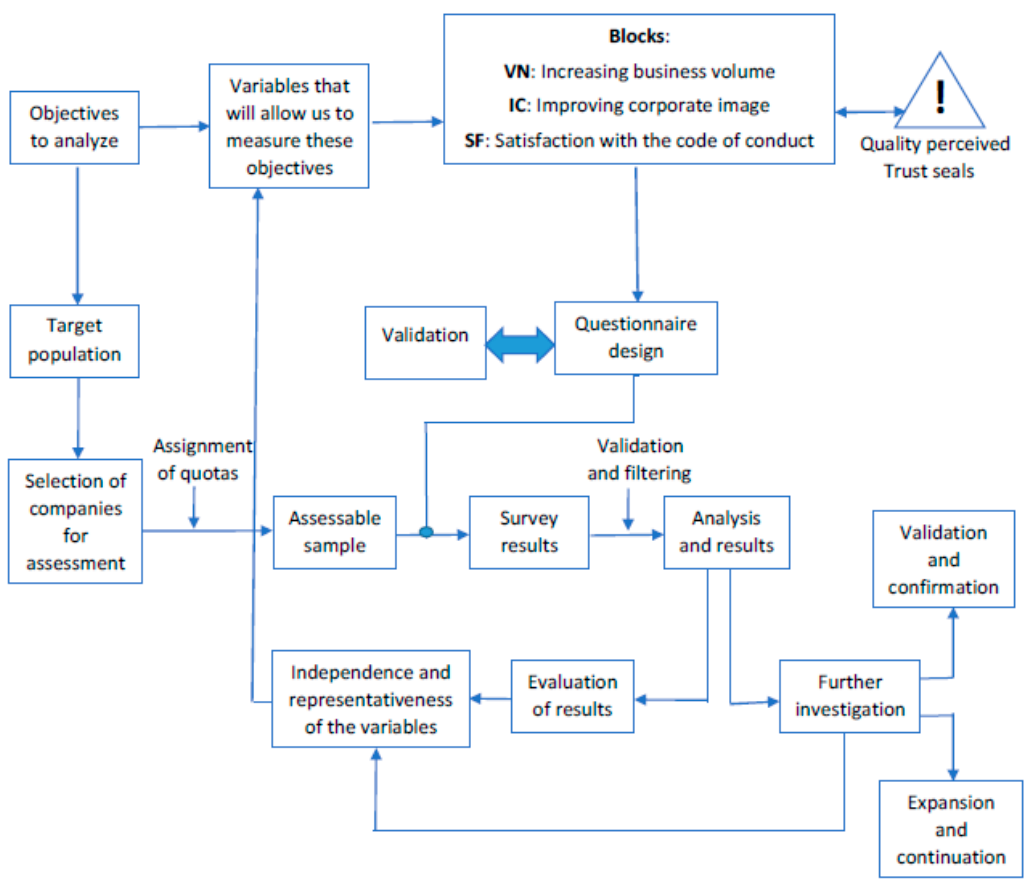
Figure 2. Research method diagram.